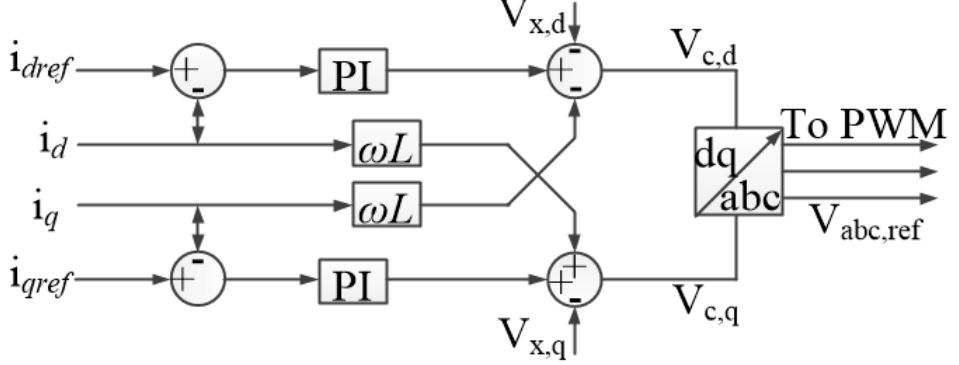
Figure 4. Inner current controller diagram.